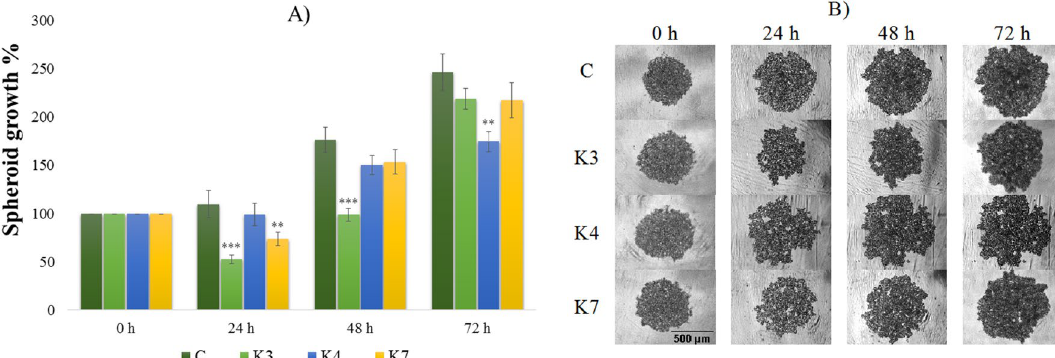
Figure 4. The impact of K3 , K4 , and K7 (1 µM) on resistant HOC/ADR spheroids formation after 24, 48, and 72 h exposure ( A ). Representative images of resistant HOC/ADR spheroids at 0 to 72 h of experiment ( B ), scale bar = 500 µm. The control spheroids ( C ) were treated with 1% V/V DMSO. After incubation, the spheroid areas were determined and the spheroid growth was calculated ( A , relative to control). Data are expressed as the average of spheroid growth (%) of nine repetitions with the corresponding standard error of the mean. The statistical differences between the control spheroids and treated spheroids were calculated by using a two- compound t-test at the level *p < 0.05, **p < 0.01, ***p < 0.001.